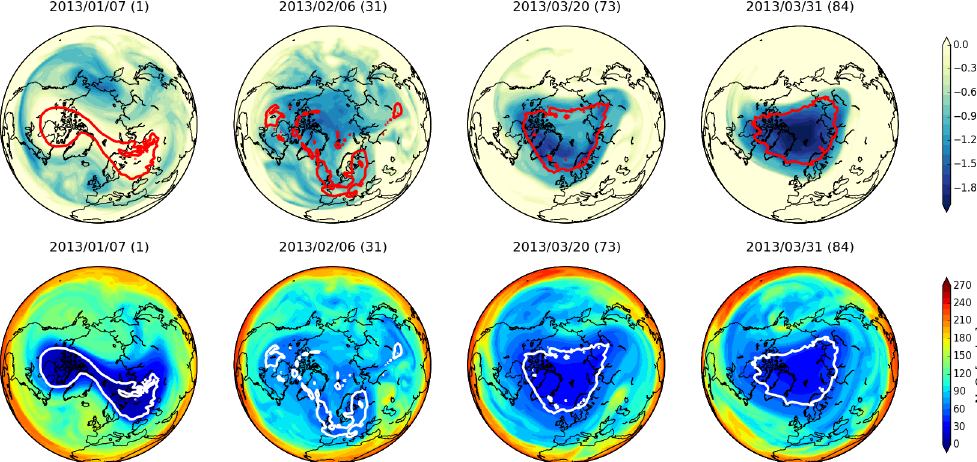
Figure 5. Ozone loss (top panels, in ppmv) and N 2 O (bottom panels, in ppbv) maps in the mid-stratosphere (600–800K) for four selected dates in early 2013. The date format is YYYY/MM/DD. The number of days after the SSW central date (6 January 2013) is given in brackets. Thus, the first map corresponds to the SSW onset, the second one to the break-up of the polar vortex, the third one to the recovery of the vortex, and the last map corresponds to the beginning of the